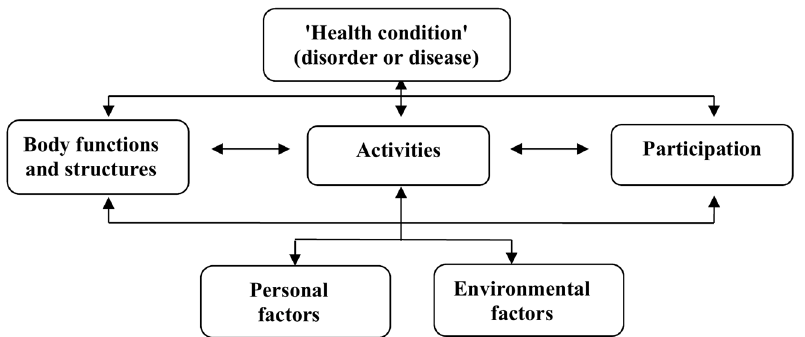
Figure 1. The International Classification of Functioning, Disability and Health: Children and Youth Version [8]. Reproduced with permission of the World Health Organization.